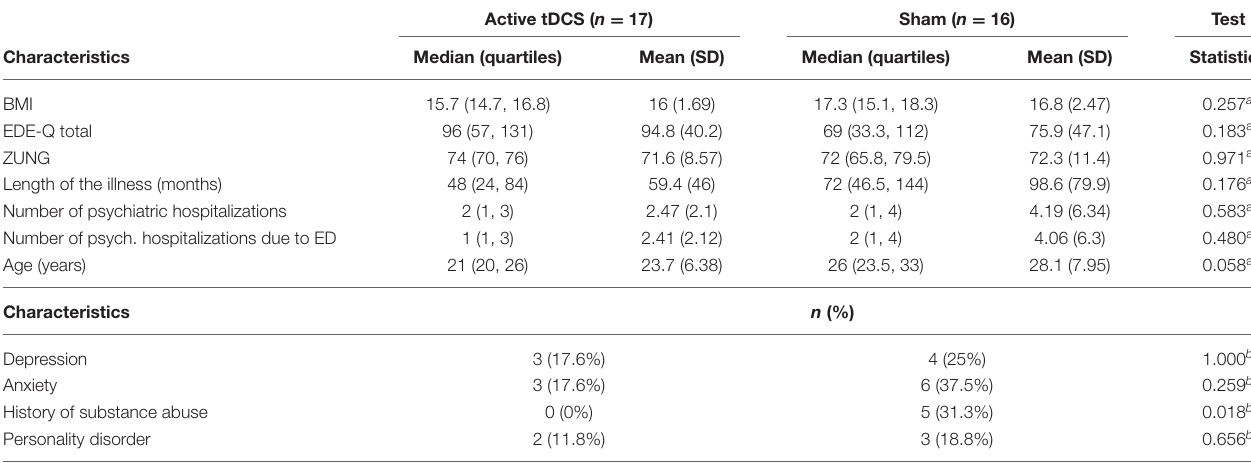
TABLE 1 | Baseline demographic and clinical characteristics of the study